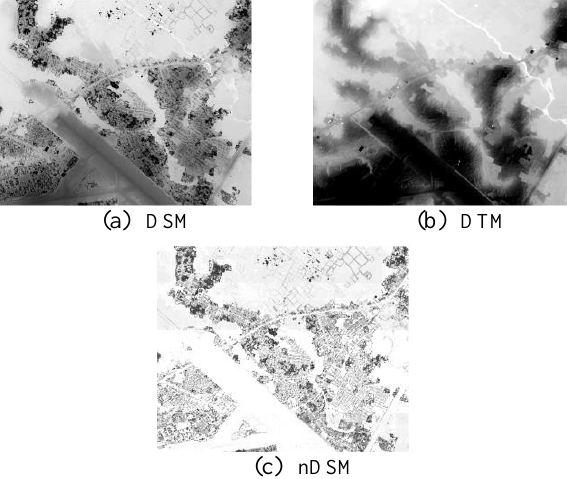
Figure 2. The DSM, DTM and nDSM data of the study area